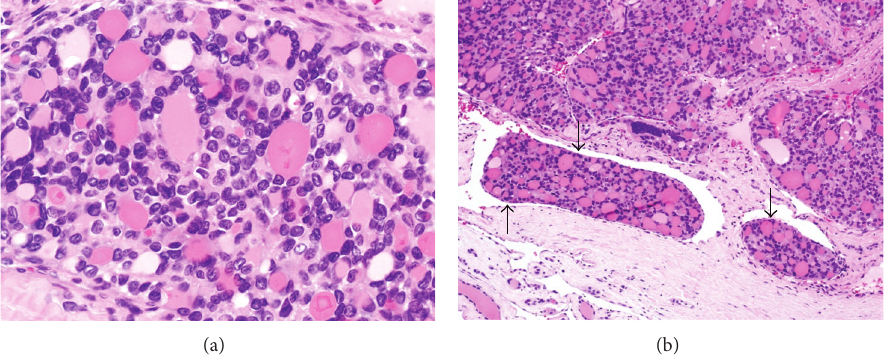
Figure 1: Histopathological examination of the left thyroid lobe showing papillary thyroid carcinoma (H&E stain). (a) Tumor cells form follicles lined by cells with typical nuclear features of papillary thyroid carcinoma of crowded enlarged nuclei with prominent nuclear grooves. (b) There are several foci of vascular invasion. Note the endothelial lining of tumor emboli (arrows).